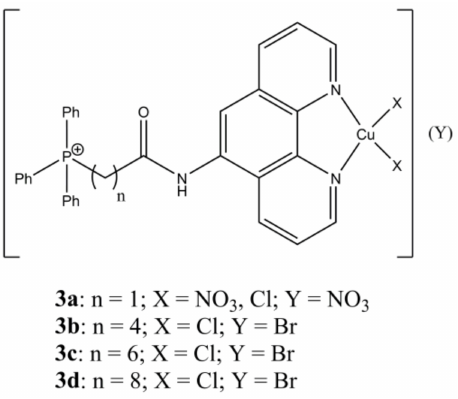
Figure 3. Structures of the [Cu(LPTn) x (X) y ](Y) z complexes. Both cellular uptake and activity on cervical (Hela) and ovarian (SKOV-3) cancer cells appear directly correlated with the lipophilicity of the LPTn ligand, while all of them showed mild toxicity towards healthy HK-2 cells. Intracellular ROS production and